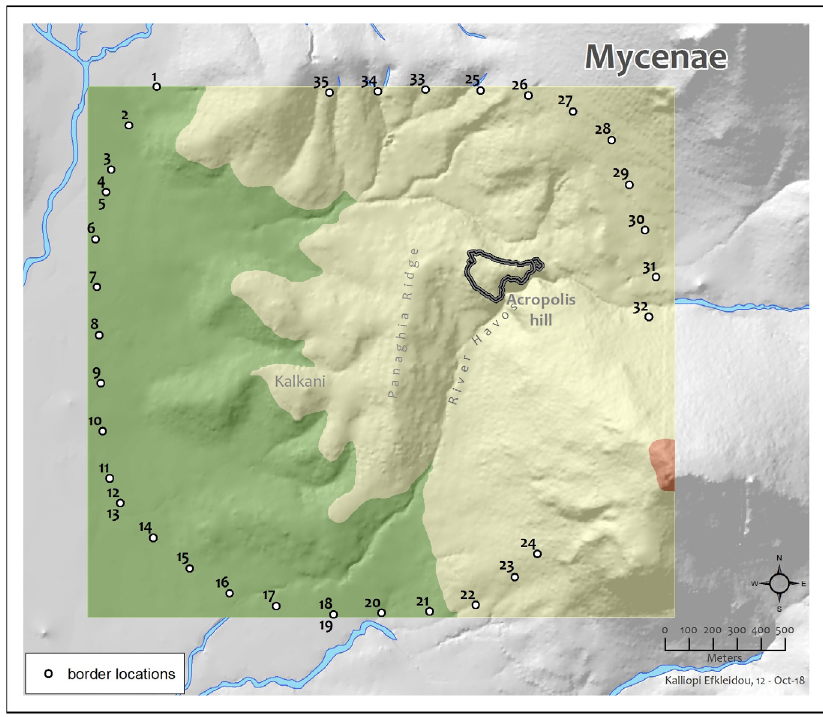
Figure 4. Destination locations encircling the study area for modelling optimal LCPs originating from the acropolis of